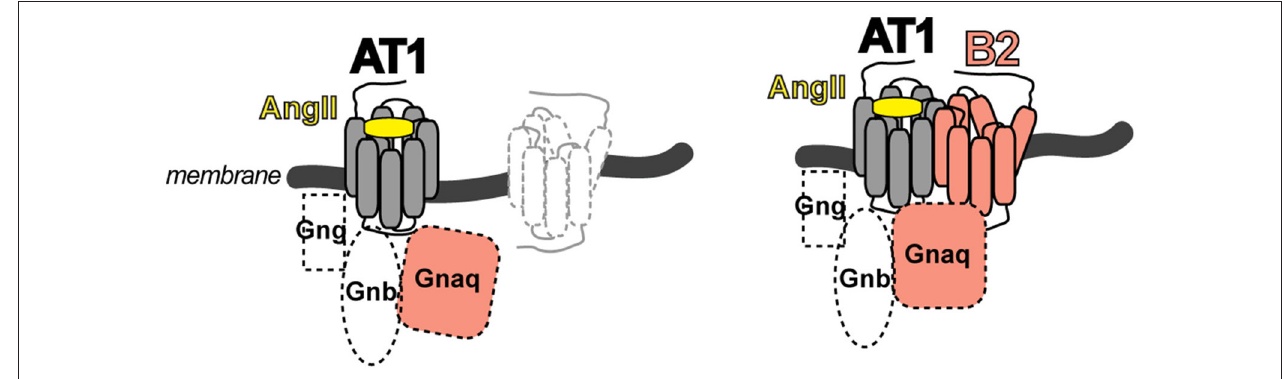
FIGURE 2 | Scheme of the AT1-B2 heteromer, which forms a platform for enhanced G-protein activation (right) compared to a monomeric AT1 receptor (left)